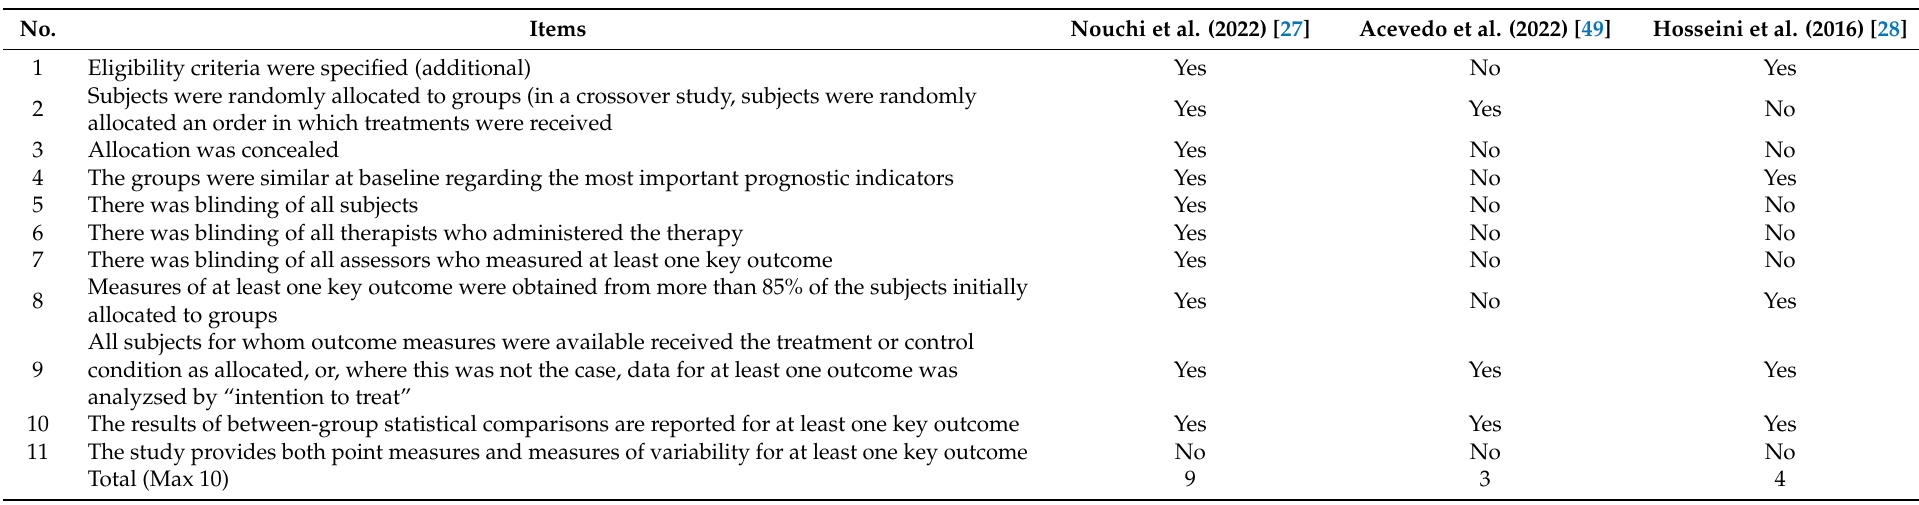
Table 2. Quality assessment scores of studies for meta-analysis using the PEDro